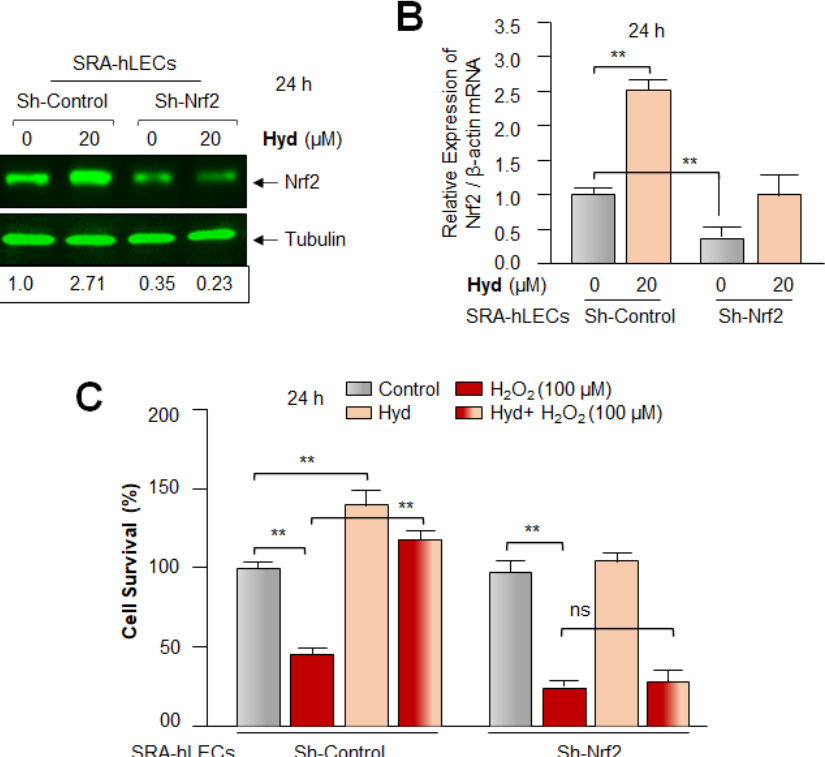
Figure 8. Nrf2 knockdown experiment disclosed that Hyd exerted its cytoprotective effect via Nrf2 pathway. ( A , B ) SRA-hLECs were transfected with either control Sh RNA or Nrf2 Sh RNA. The transfectants bearing Sh -Control or specific Sh -Nrf2 were treated with Hyd for 24 h. Total cell lysate and RNA were isolated and submitted to Western blot and RT-qPCR analyses with probes specific to Nrf2, respectively. Numbers under each protein band denote the value of Nrf2 band normalized with corresponding tubulin protein bands. The histogram data represent the mean ± S.D. values derived from three independent experiments. ** p < 0.001. ( C ) Nrf2 knockdown experiments demonstrated that Hyd protected LECs via Nrf2-mediated protective pathway. Sh -Control or Sh -Nrf2 SRA-hLECs as shown above in Figure 8A,B exposed to H 2 O 2 in absence or presence of Hyd as indicated. Hyd- treated transfectants containing sh RNA specific to Nrf2 demonstrate a significant increase in cell death compared to Sh Control counterpart as evidenced by MTS assay. All histogram data represent the mean ± S.D. values obtained from three independent experiments. ** p < 0.001, ns; denotes